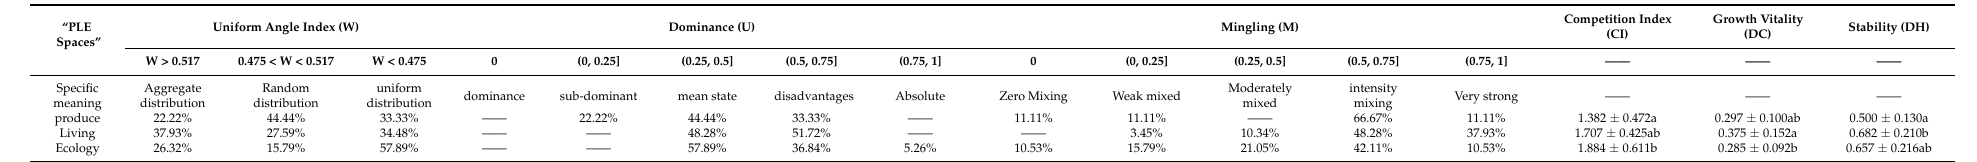
Table 7. Structural and non-structural parameters of the plant community under the “production-living-ecological” spaces.